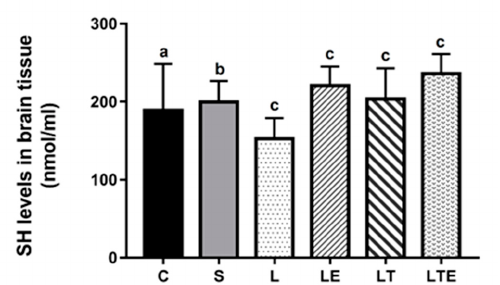
Figure 9. Evaluation of SH levels in the brain. Brain sulfhydryl levels (nmol / mL) after interventions in the di ff erent groups: C, control group; S, sham group; L, injury group; LE, injury + extract group; LT, injury + training group; LTE, injury + training + extract group. Values are expressed as mean ± standard deviation ( n = 10 in each group). The letters “a”, “b” and “c” when repeated indicate statistical di ff erences between the groups as determined by one-way ANOVA with Bonferroni post-hoc corrections.